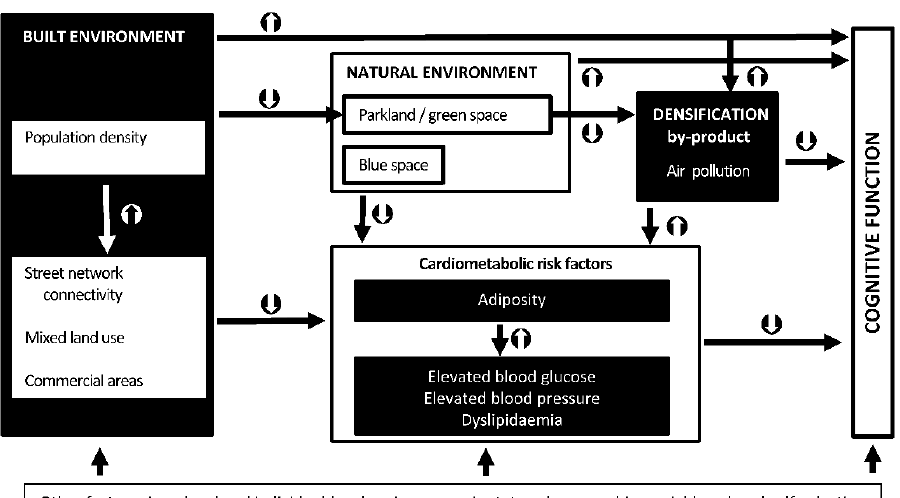
Figure 1. A simplified ecological model of neighbourhood environmental influences on cognitive function. indicate positive associations; indicate negative associations.